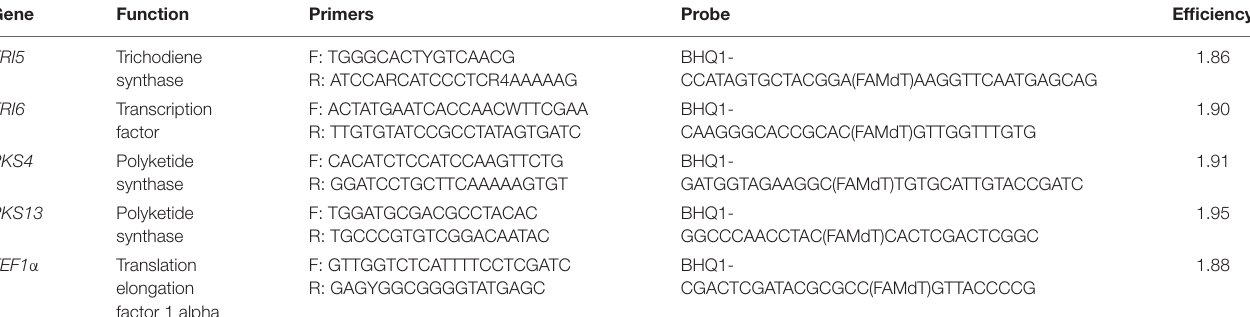
TABLE 2 | Gene-specific primers and hydrolysis probes